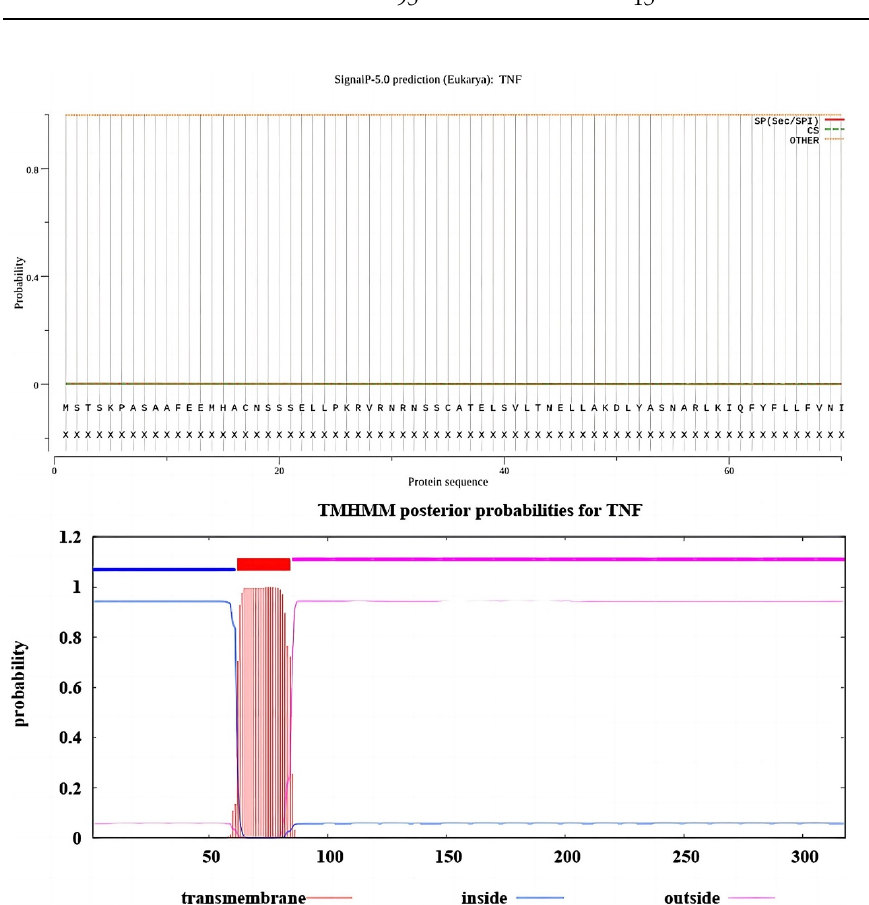
Figure A1. The oTNF signal peptide and transmembrane domain prediction results. The above panel shows that the probability of a signal peptide being present in the amino acid sequence of TNF is extremely low (0.0361), so it is assumed that no signal peptide is present in this protein. The predicted transmembrane domain results showed that amino acids 1–61 of the protein were located within the cell membrane, amino acids 62–84 were in the transmembrane region, and amino acids 85–318 were predicted to be in the extracellular